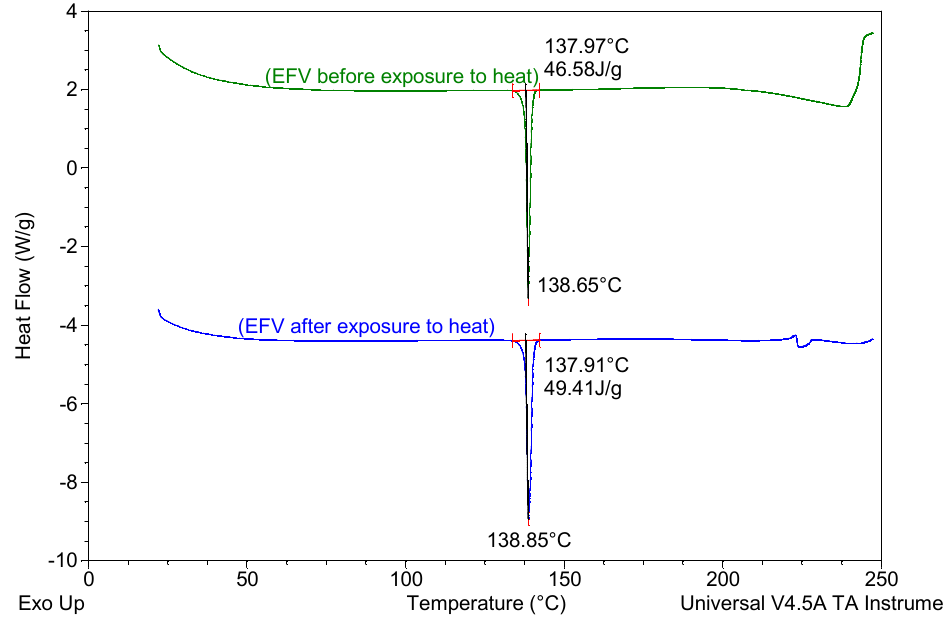
Figure 8. DSC thermograms of EFV prior to and following exposure to a temperature of 70 °C for 1 h.